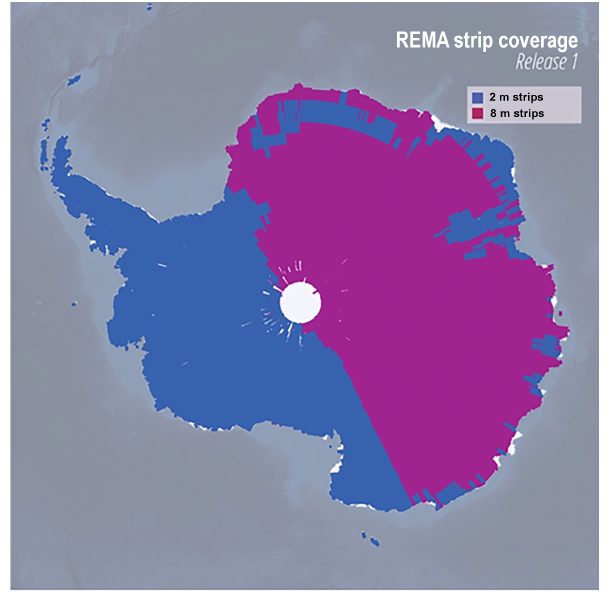
Figure 9. Map showing coverage of 2 and 8m resolution of DEM strips in the REMA version 1